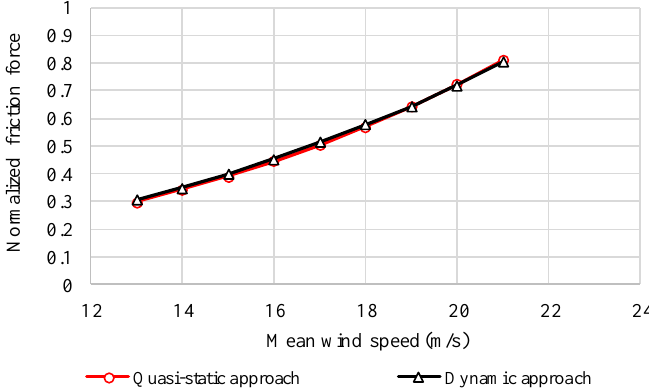
Figure 16. Normalized friction force on front axle of the van according to mean wind speed.